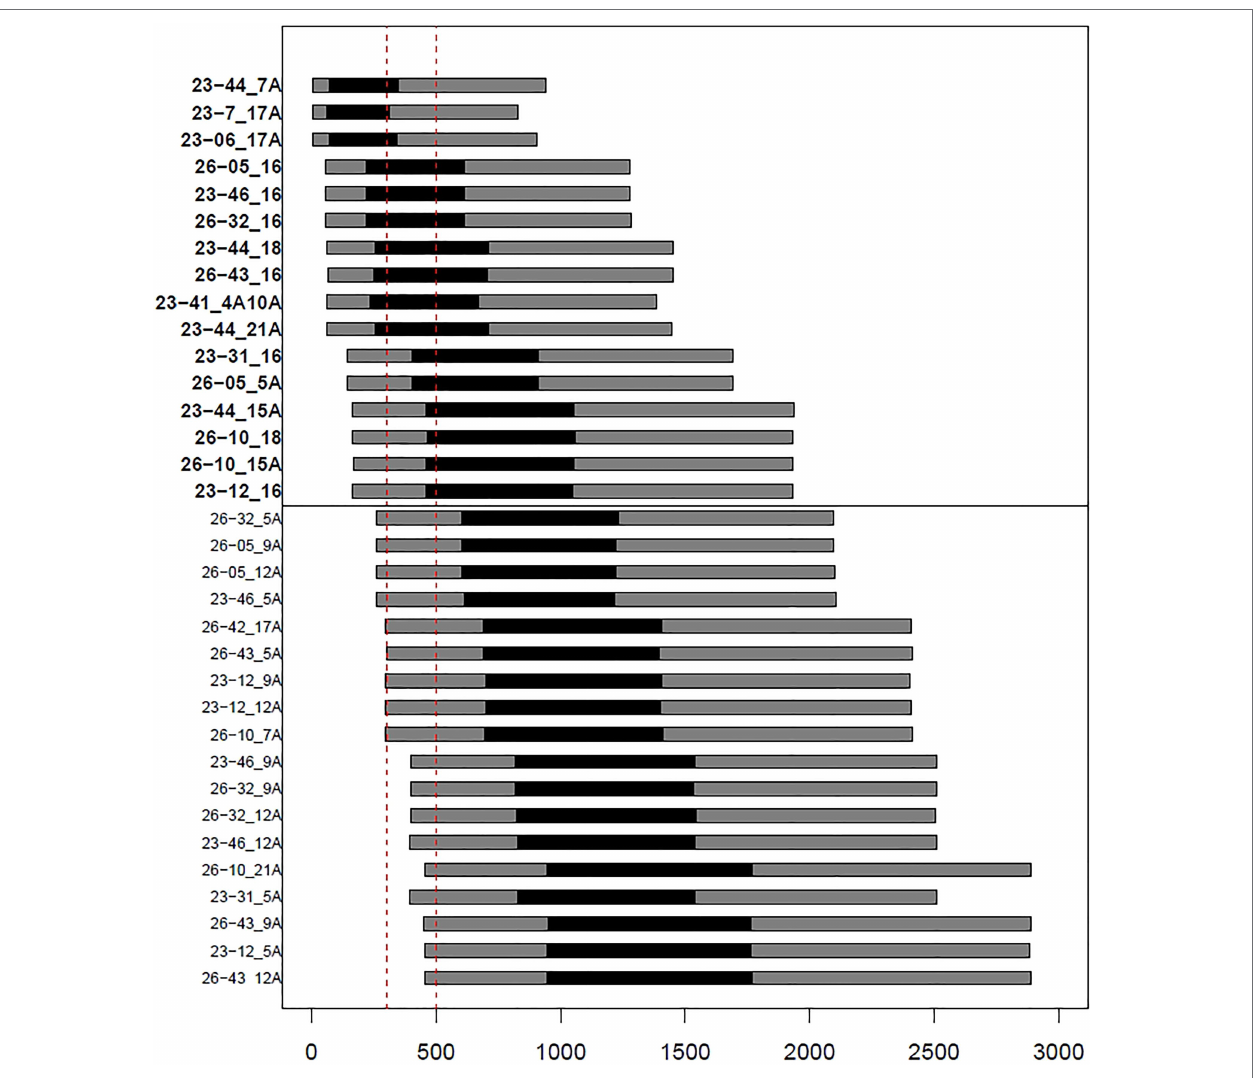
FIGURE 3 | Barplots representing confidence intervals (black: 50% CI; gray: 95% CI) of estimates of times separating ancient and modern samples. Vertical dashed lines (in red) delineate the chronological window of Roccapelago mummies (~300–500 years ago). The upper panel shows pairs with best-matching results (i.e., overlap between mummies chronological window and the 50% CIs of time